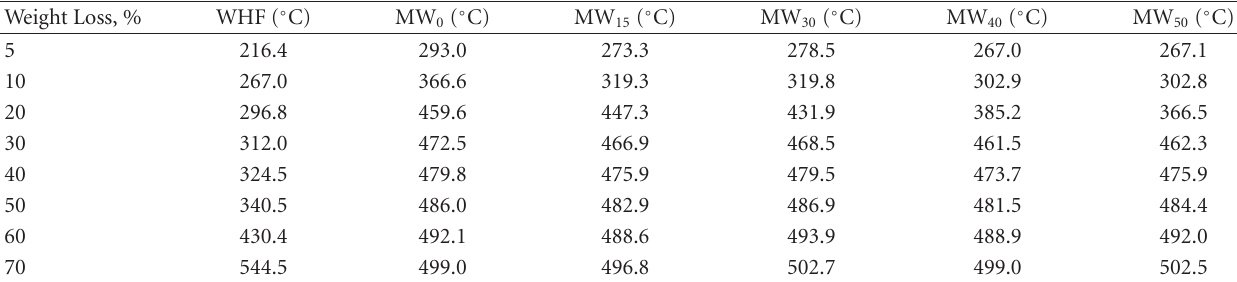
Table 5: Decomposition temperatures of WHF, EPDM, and WHF-EPDM vulcanizates at various weight-loss %.